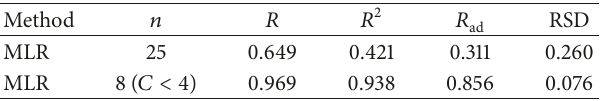
Table 11: Loadings of the first three principal components. Comp. 1 Comp. 2 Comp.